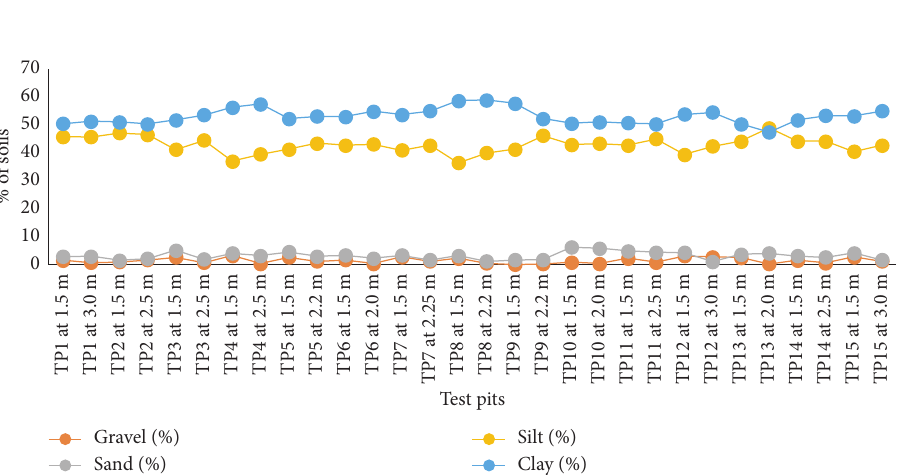
Figure 2: Percentage of gravel, sand, silt, and clay of the study